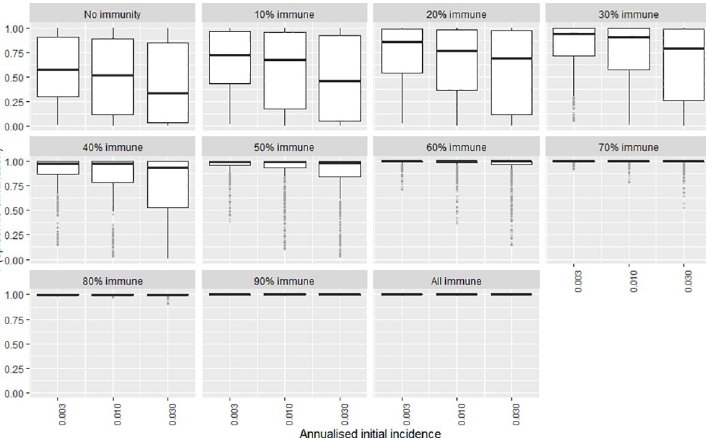
Fig 12. The certainty of the effect of initial incidence on P(elim.) at different herd immunities. The range of possible values when other parameters not shown in this plot are varied over their ranges. The boxplot shows the median, the interquartile range, minimums and maximums (1.5 times the 1 st and 3d quarter values) and outliers (grey circles).